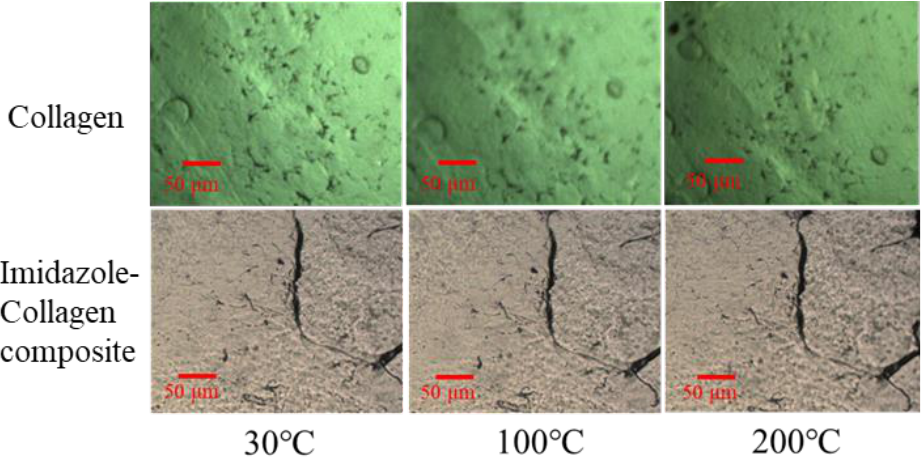
Figure 3. Micrographs of the collagen film and imidazole–collagen composite film ( n = 2.0) under the microscope at 25 °C and 200 °C .